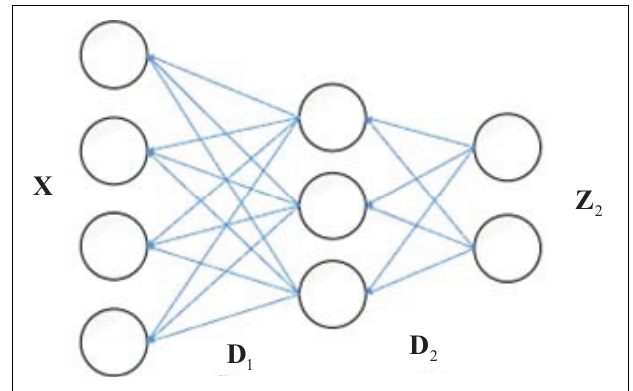
FIGURE 1 | The schematic diagram of two-layer dictionary